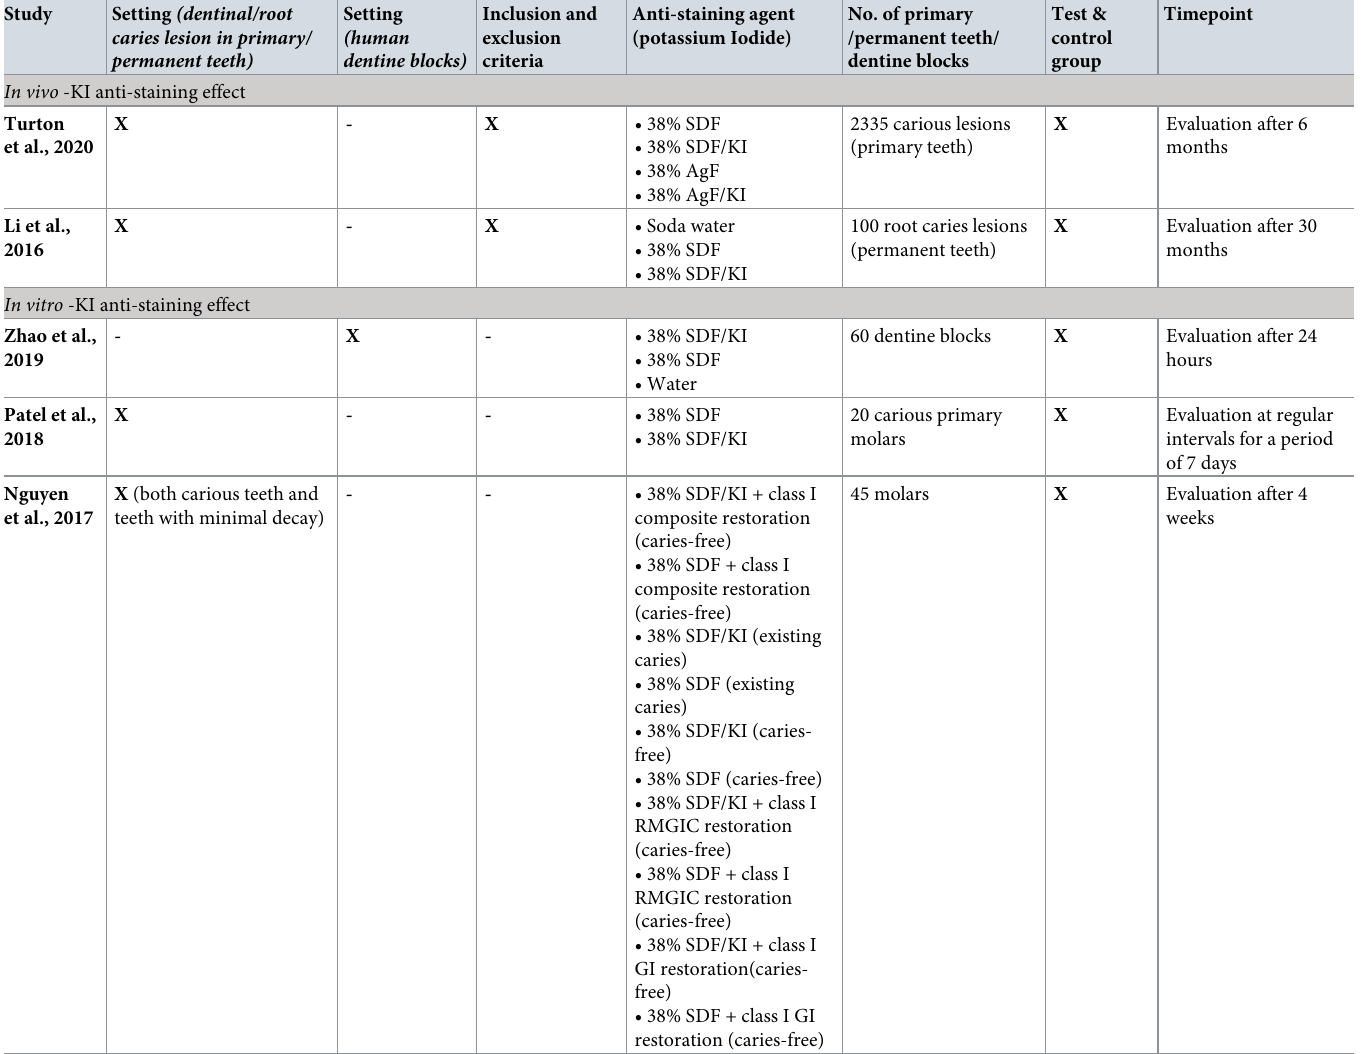
Table 2. Characteristics of the included studies on the anti-staining effect of KI post-SDF